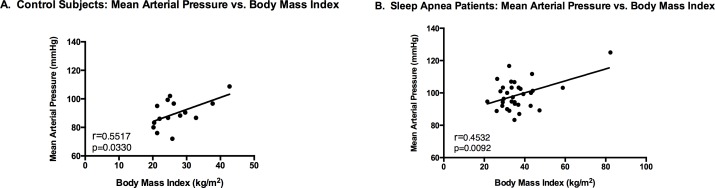
Correlation between Mean Arterial Pressure and Body Mass Index by Group Panel A depicts the individuals within the control group, and Panel B depicts the patients within the sleep apneic group.